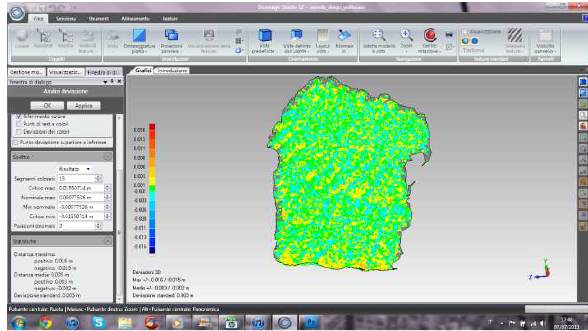
Figure 7. The deviations points-model (from the C10 scans) for the wing of the